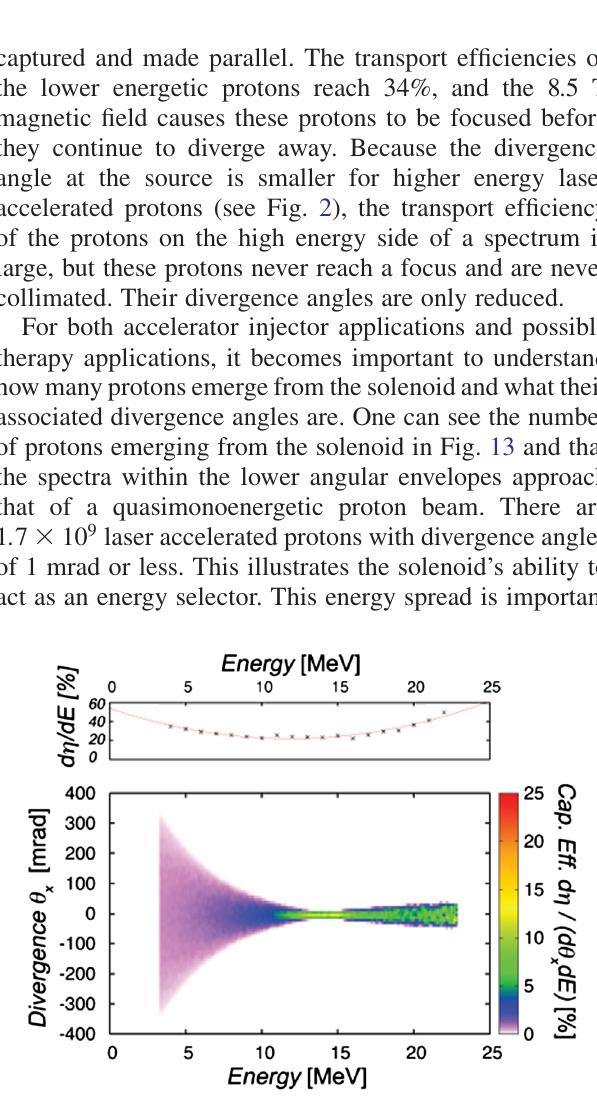
FIG. 12. Divergence angles (cid:1) x of protons after passing through the 8.5 T field of the solenoid. The color density indicates the transport efficiency d(cid:4)= ð d (cid:1) x dE Þ for a single energy and single angle while the top is a projection showing the total transport efficiency d(cid:4)=dE for a single energy across all angles. As governed by the 8.5 T field, 13.75 MeV protons are collimated with near collimation of the 13 : 75 (cid:5) 1 : 25 MeV protons.